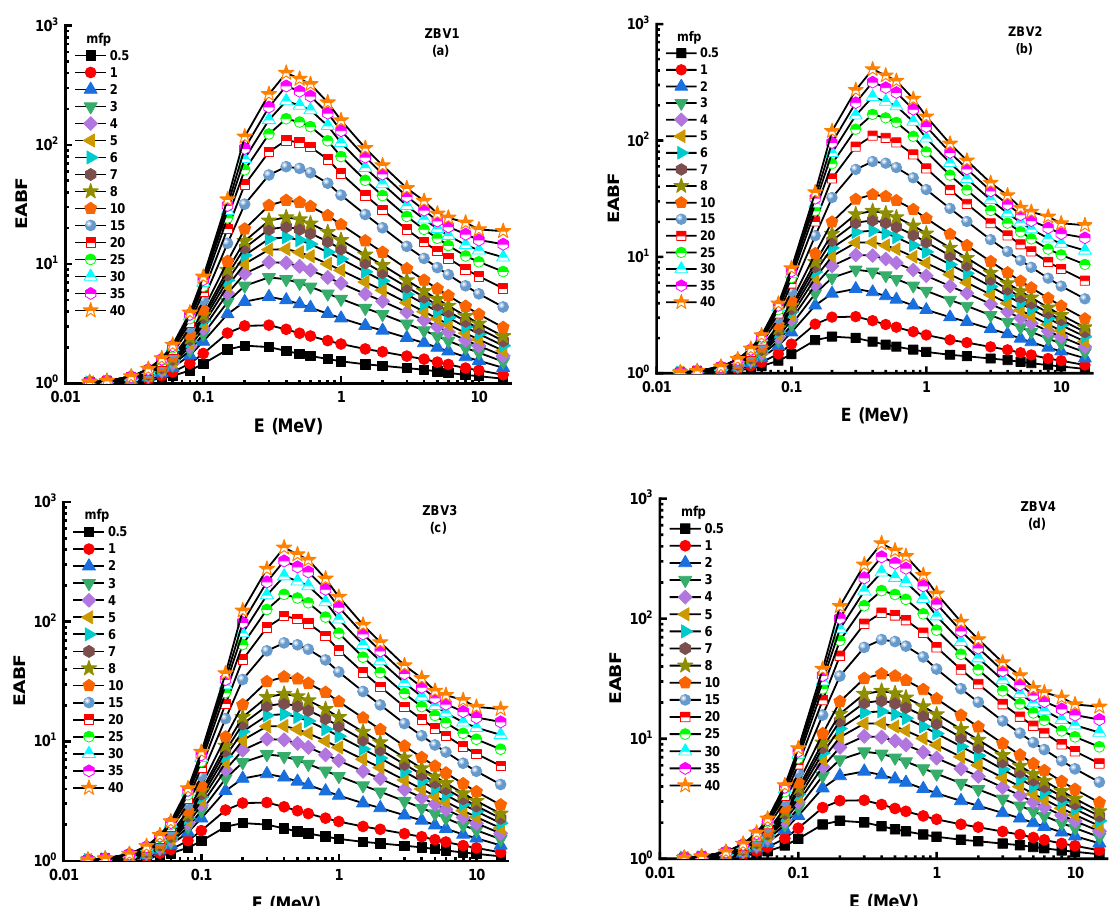
a V 2 O 5 reinforcement amount from 1 to 4 mol.%. As a last analysis of EBF and EABF val- ues, Figure 13 shows the variations in the energy-absorption buildup factor (EABF) and exposure buildup factor (EBF) against effective atomic number (Z eff ) for all glasses at 1 MeV/5 mfp. This is another sign of the synergistic effect of V 2 O 5 reinforcement, which caused a decrement in densities of glasses, and in gamma-ray-shielding competencies ac- cordingly. As illustrated in Figure 13, EBF values increased gradually from ZBV1 to ZBV4. This trend was a natural consequence of variations in effective atomic numbers, which was discussed in previous sections. Figure 10. ( a – d ): Variation of energy-absorption buildup factor (EABF) against photon energy for all glasses. Table 3. (EBF and EABF) G–P fitting coefficients for the ZBV1 glass sample.